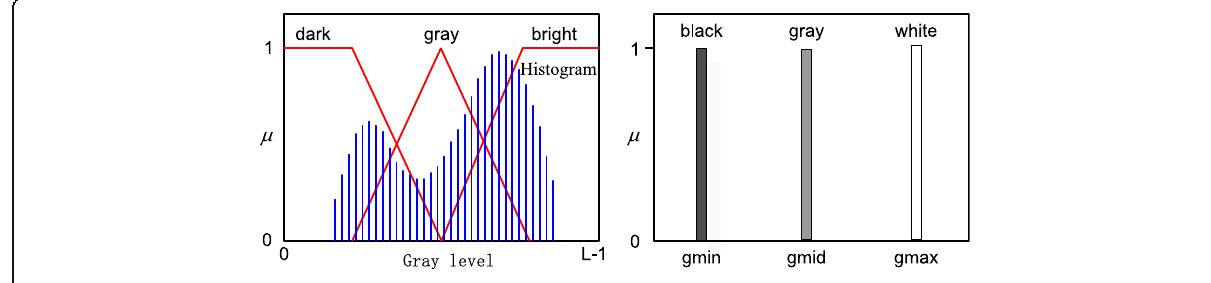
enhancement balance 3. Weighted mean filtering → blur sharpening → grayscale stretching Figure 7 is an original image after a cumulative average of a static image of a 100-frame electromagnetic leak emission reduction sample. Figures 8, 9, and 10 are image effect diagrams processed by the combination of the above various